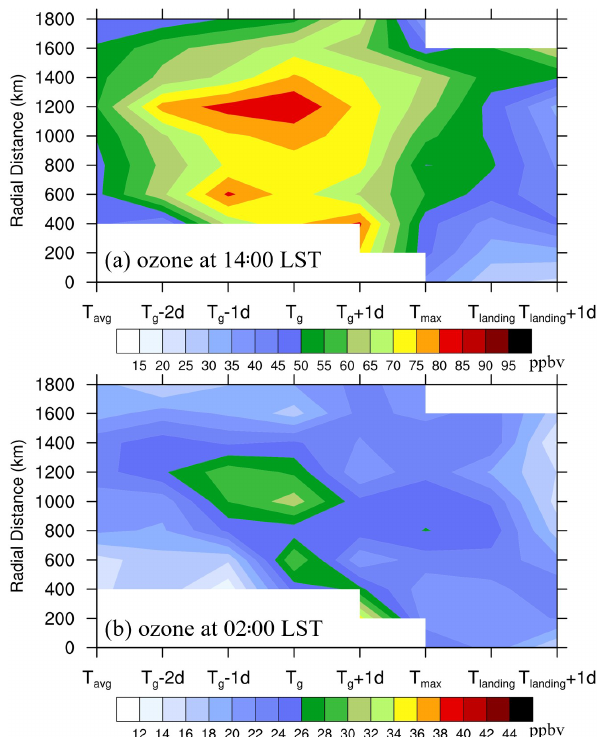
Figure 2. Surface ozone concentrations (in ppbv) along the radial distance of typhoons at various typhoon developmental stages at daytime (a) and night-time (b) . The concentrations are the mean ozone concentrations of all of the typhoons over the 2014–2018 pe- riod. The surface ozone concentration data are from the China Na- tional Environmental Monitoring Centre, and the white sections in the bottom-left and top-right parts of the panels are due to missing